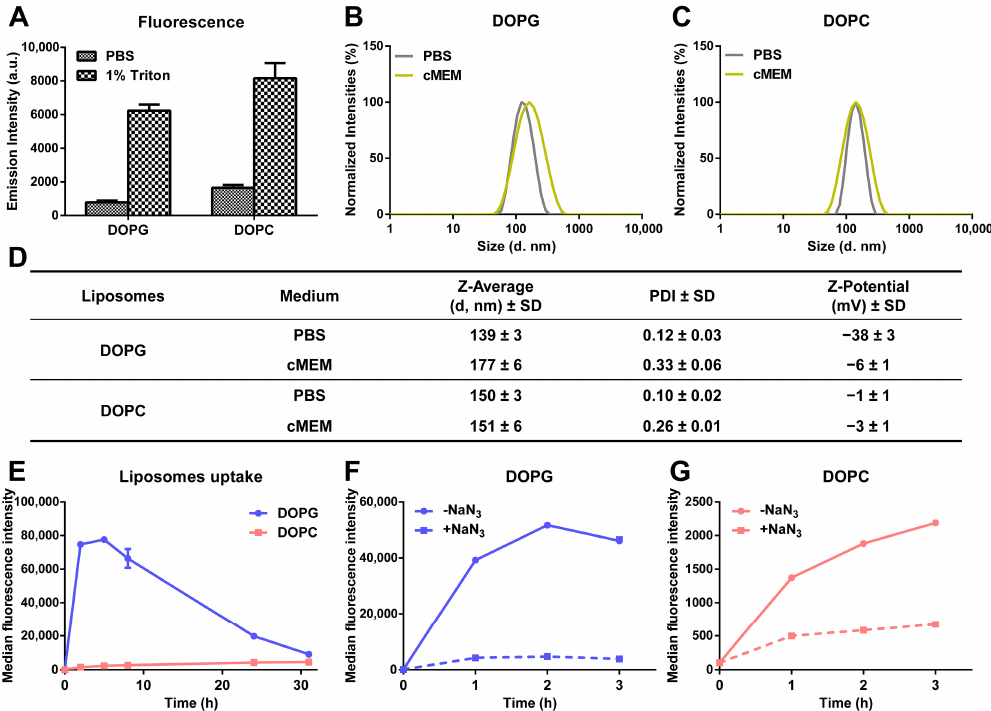
Figure 1. Characterization of the physicochemical properties and cellular uptake behavior of lipo- somes. ( A ) SRB fluorescence of liposomes dispersed in PBS and 1% triton. A total of 62 µ g/mL liposomes was dispersed in PBS and 1% triton, and SRB fluorescence was measured immediately. The mean and standard deviation of the results obtained on 3 replicate samples are reported. Higher fluo- rescence was detected after dispersion in triton, indicating that the fluorescence of SRB was partially quenched inside liposomes. ( B , C ) Size distribution by intensity of DOPG ( B ) and DOPC ( C ) liposomes in different media. A total of 62 µ g/mL liposomes was dispersed in PBS and cell culture medium supplemented with 10% FBS (cMEM) and their size distribution measured by DLS as described in Methods. The narrow distributions and low polydispersity confirmed the homogenous properties of liposomes after preparation by extrusion and when introduced in cMEM liposomes remained stable. ( D ) Z-average hydrodynamic diameter (d, nm) and polydispersity index (PDI) extracted by cumulant analysis of DLS data and zeta potential of liposomes dispersions (62 µ g/mL) in PBS and cMEM. ( E ) Uptake kinetics of liposomes in cMEM. HeLa cells were exposed to 62 µ g/mL DOPG or DOPC liposomes in cMEM and cells were collected for flow cytometry measurement after different exposure times as described in Methods. The results are the mean and standard deviation over 2 replicates of the median cell fluorescence intensity. ( F , G ) Uptake of DOPG ( F ) and DOPC ( G ) liposomes in energy-depleted cells. Briefly, Hela cells were pre-incubated with 5 mg/mL sodium azide (NaN 3 ) for 30 min to deplete cell energy, then exposed to 62 µ g/mL liposomes in cMEM in the presence of NaN 3 , followed by cell fluorescence measurement by flow cytometry as described in Methods. Uptake in standard conditions was also measured for comparison (-NaN 3 ). Exposure to NaN 3 strongly reduced uptake, indicating that both liposomes were internalized by cells via energy-dependent